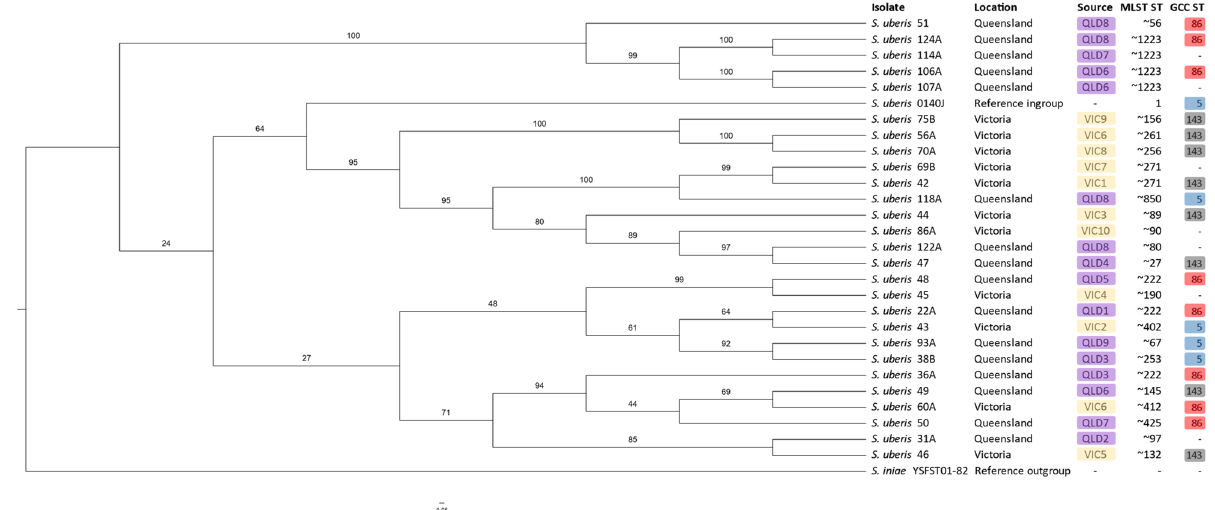
Figure 3. Maximum likelihood phylogenetic tree based on core genome alignment between the S. uberis isolates identified in this study. S. iniae YSFST01-82 (accession number: GCF_000831485.1) was used as an outgroup and S. uberis 0140J (accession number: AM946015) (MLST ST1, GCC ST5) as an ingroup. Bootstrap values are shown in numbers along branches. Purple labels show Queensland isolates. Yellow labels show Victorian isolates. MLST STs are shown, as well as GCC STs. GCCs are coloured, GCC ST86 coloured red, GCC ST 5 coloured blue, GCC ST143 coloured grey. Core genome alignment was performed in roary (version 3.13.0) 115 and maximum likelihood tree was built in RAxML version 8.2.10 (raxmlHPC-PTHREADS-SSE3) 120 with 1000 replicates. Tree visualised in FigTree version 1.4.4 (http://tree.bio.ed.ac.uk/softw are/figtr ee/). For figure clarity, the phylogenetic tree was visualised using a cladogram transformation. Data S1 shows the untransformed tree, along with an isolate-only tree which shows very high bootstrap support at almost every node (~ 100%) due to the increased number of genes in the core genome